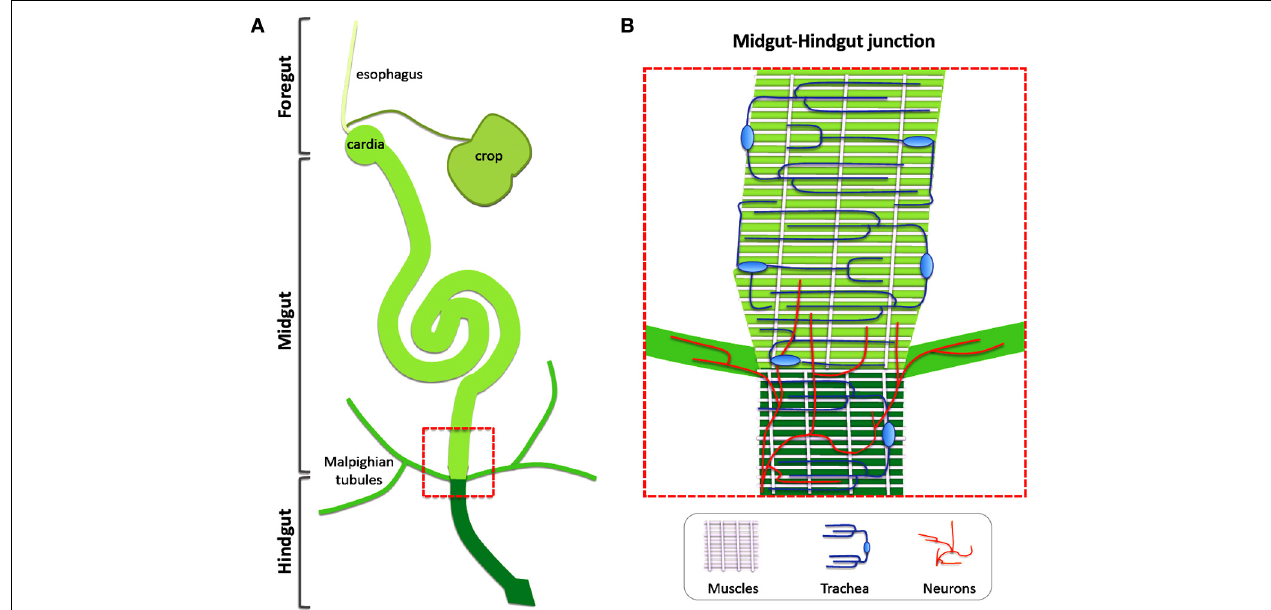
FIGURE 1 | Non-intestinal epithelial tissues are closely connected with the Drosophila gut. (A) The intestinal tract of the Drosophila adult is separated in three main domains: the foregut, the midgut and the hindgut. (B) Visceral muscles, intestinal trachea and neurons are integral parts of the intestinal tract. A zoom-up of the boxed area in (A) Corresponding to the